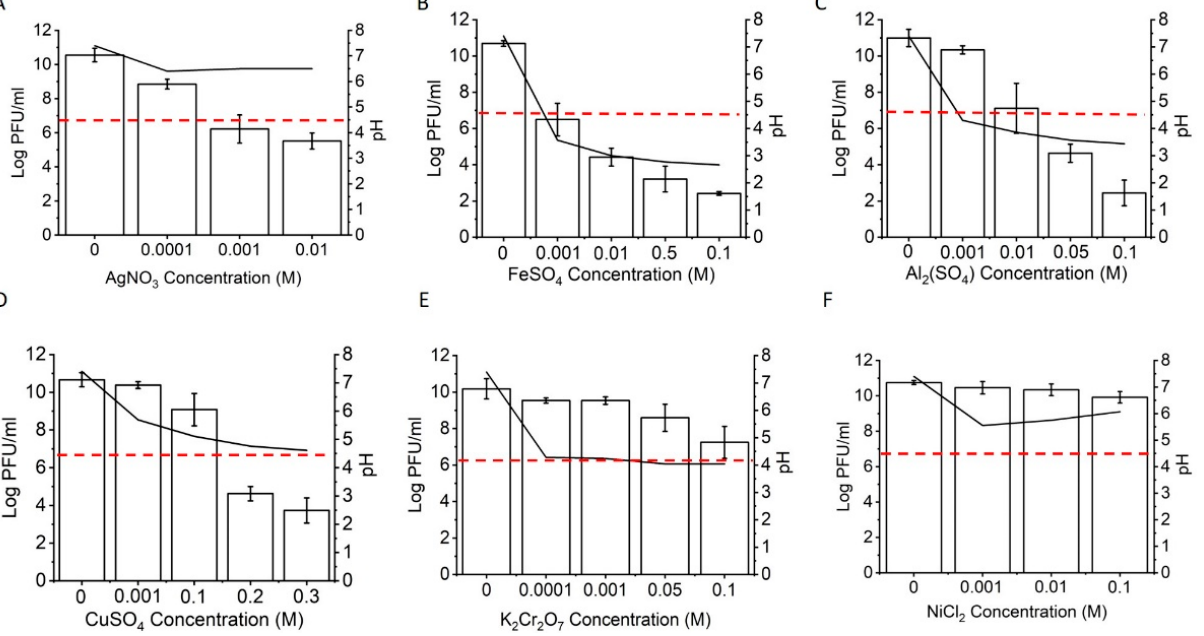
Figure 2. Phi6 viral titer after treatment with metal solutions. ( A ) Phi6 treated with silver nitrate; ( B ) ferrous sulphate; ( C ) aluminum sulphate; ( D ) potassium dichromate; ( E ) copper sulphate; ( F ) nickel chloride. On the left y-axis, PFU/mL, and on the right y-axis, pH of the solutions are presented. The black lines represent the pH of the solutions, the red dashed lines indicate the decrease in viral titer by 99.99% compared to the control. The average values and standard deviations are shown (n ≥ 3).